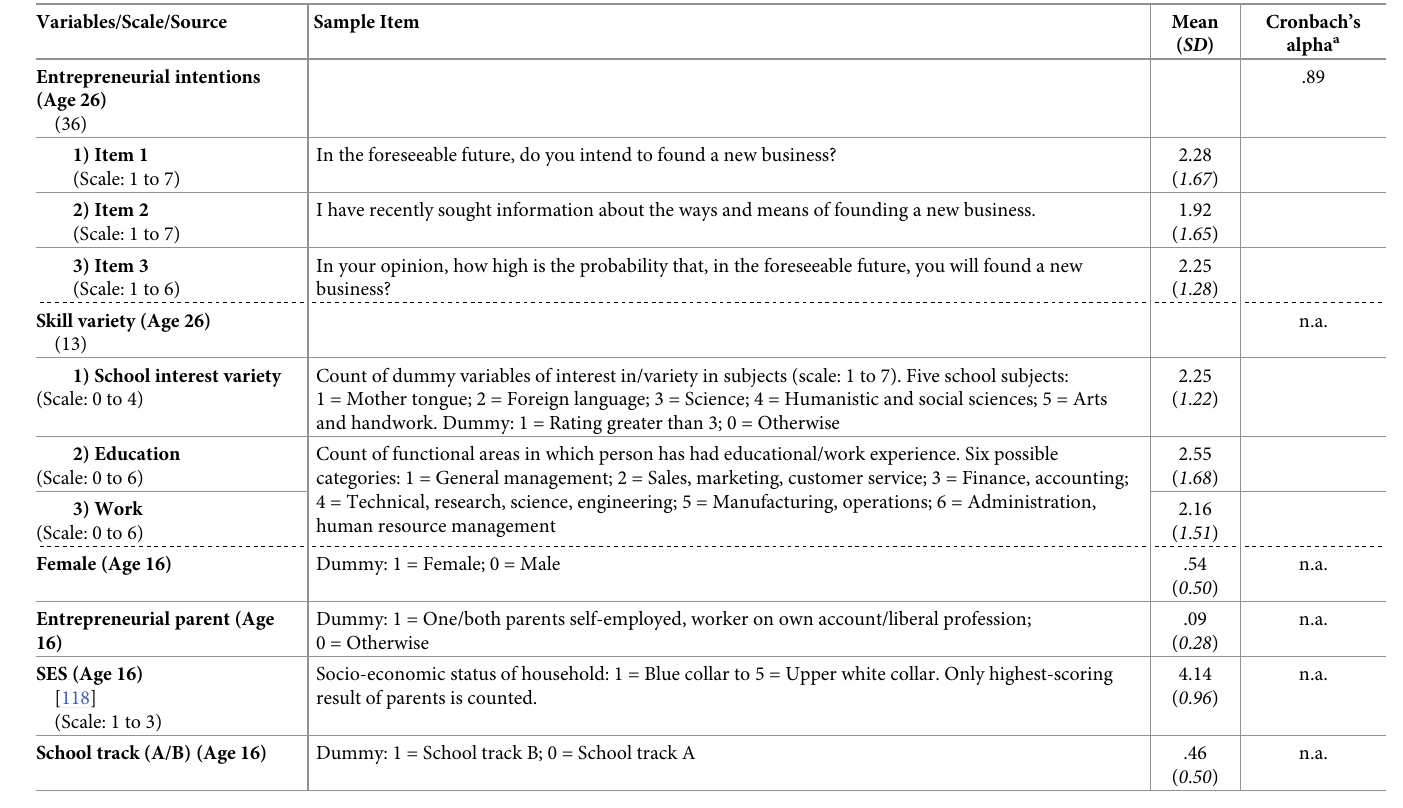
Table 1. Description of the measured